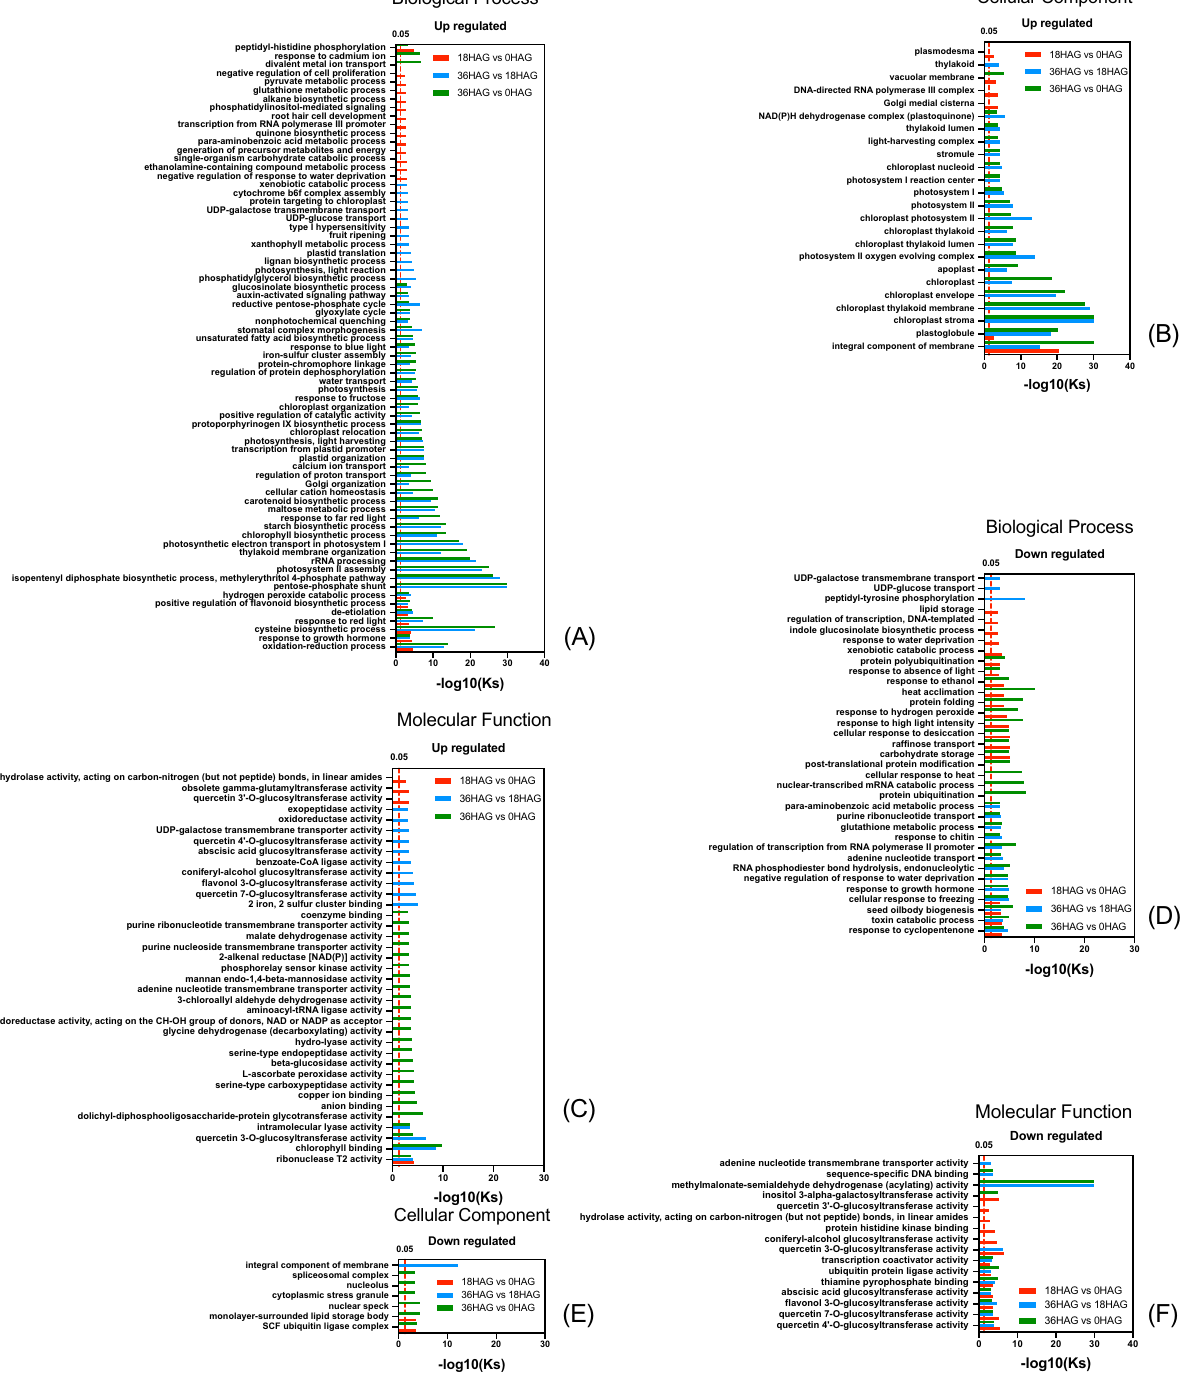
Figure 3. GO enrichment of DEGs during short-time germination. Biological process ( A ), cellular component ( B ), molecular function ( C ) of up regulated DEGs, Biological process ( D ), cellular component ( E ), molecular function ( F ) of down regulated